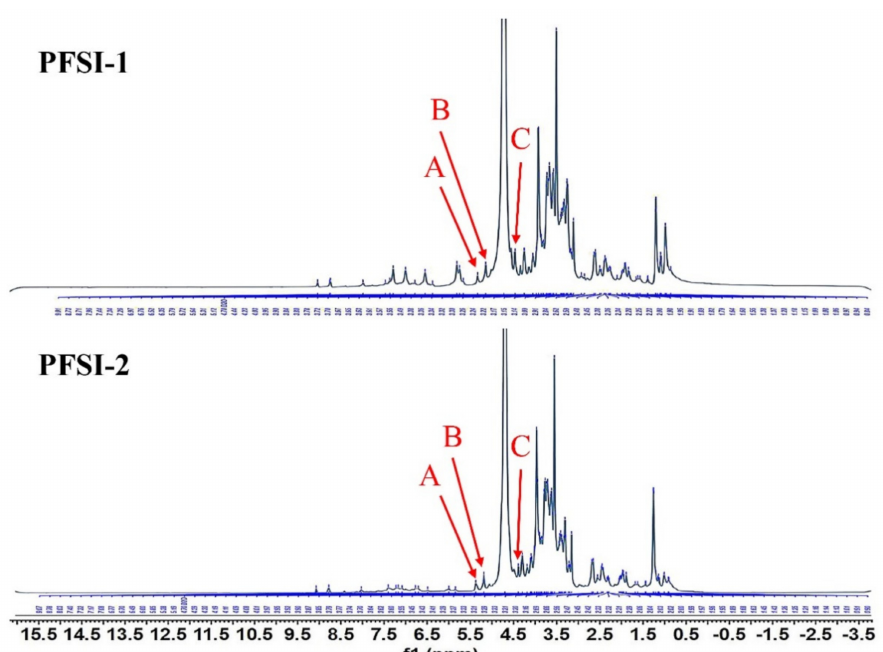
Figure 6. PFSI-1, PFSI-2 NMR hydrogen spectra (1H NMR). Note: PFSI-1 and PFSI-2 both had 3 heterotopic hydrogen signals at δ 5.31 (A), 5.12 (B), and 4.52 (C) ppm and δ 5.38 (A), 5.19 (B), and 4.49 (C) ppm in 1H-NMR, respectively, and all consisted of three kinds of saccharide residues